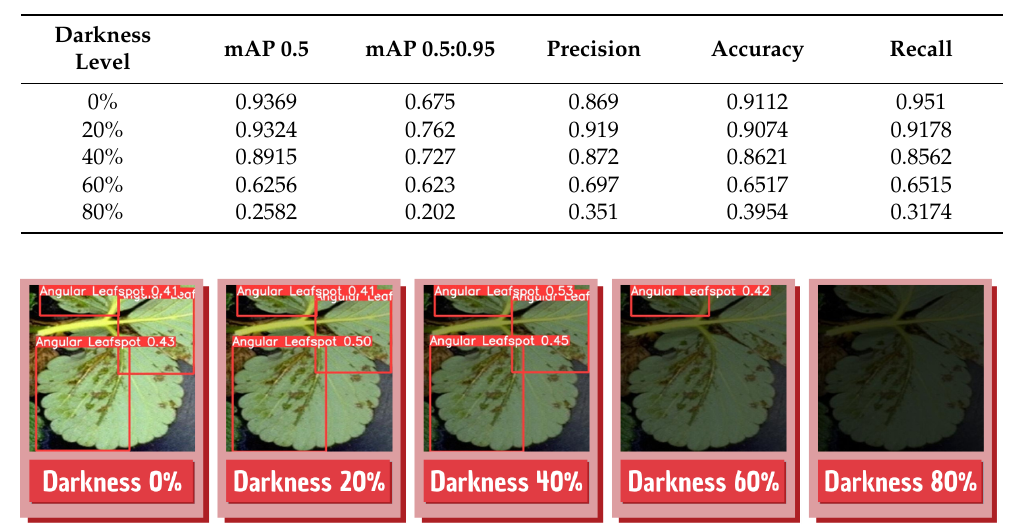
Table 6. Model performance in different brightness profiles.